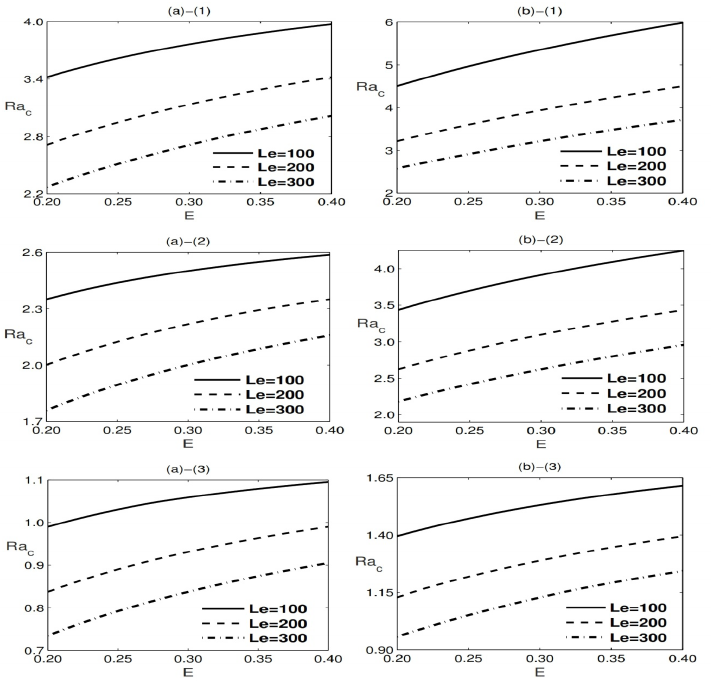
Ra as a function of E for distinct values of Le for (a) 1 J = + and (b) 1 J = − ; for (1) I_C-I_C, (2) I_C-I_CHF, and (3) Figure 4: Variation of c I_C-F_CHF